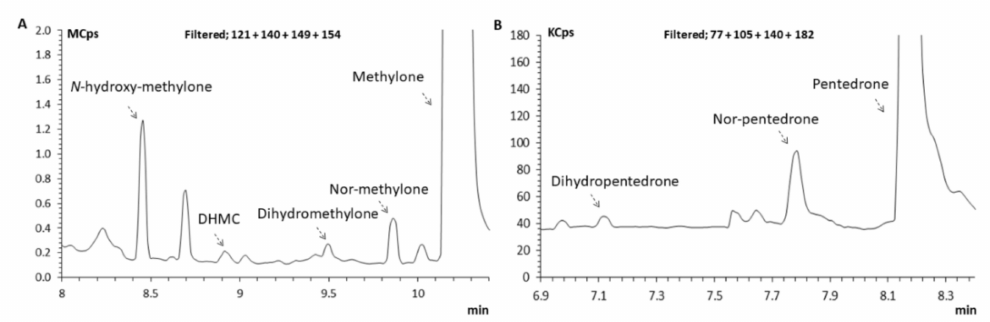
Figure 6. Zoomed full scan chromatogram of an extracted sample of HLM incubated with S -( − )- methylone and S -(+)-pentedrone for 60 min reconstructed with the following ions: ( A ) m / z = 121, m / z = 149, m / z = 140, and m / z = 154, N -hydroxymethylone (8.45 min), DHMC (8.95 min), di- hydromethylone (9.50 min), nor-methylone (9.86 min), and methylone (10.19 min); ( B ) m / z = 77, m / z = 105, m / z = 140, and m / z = 182, dihydropentedrone (7.14 min), nor-pentedrone (7.76 min), and pentedrone (8.12